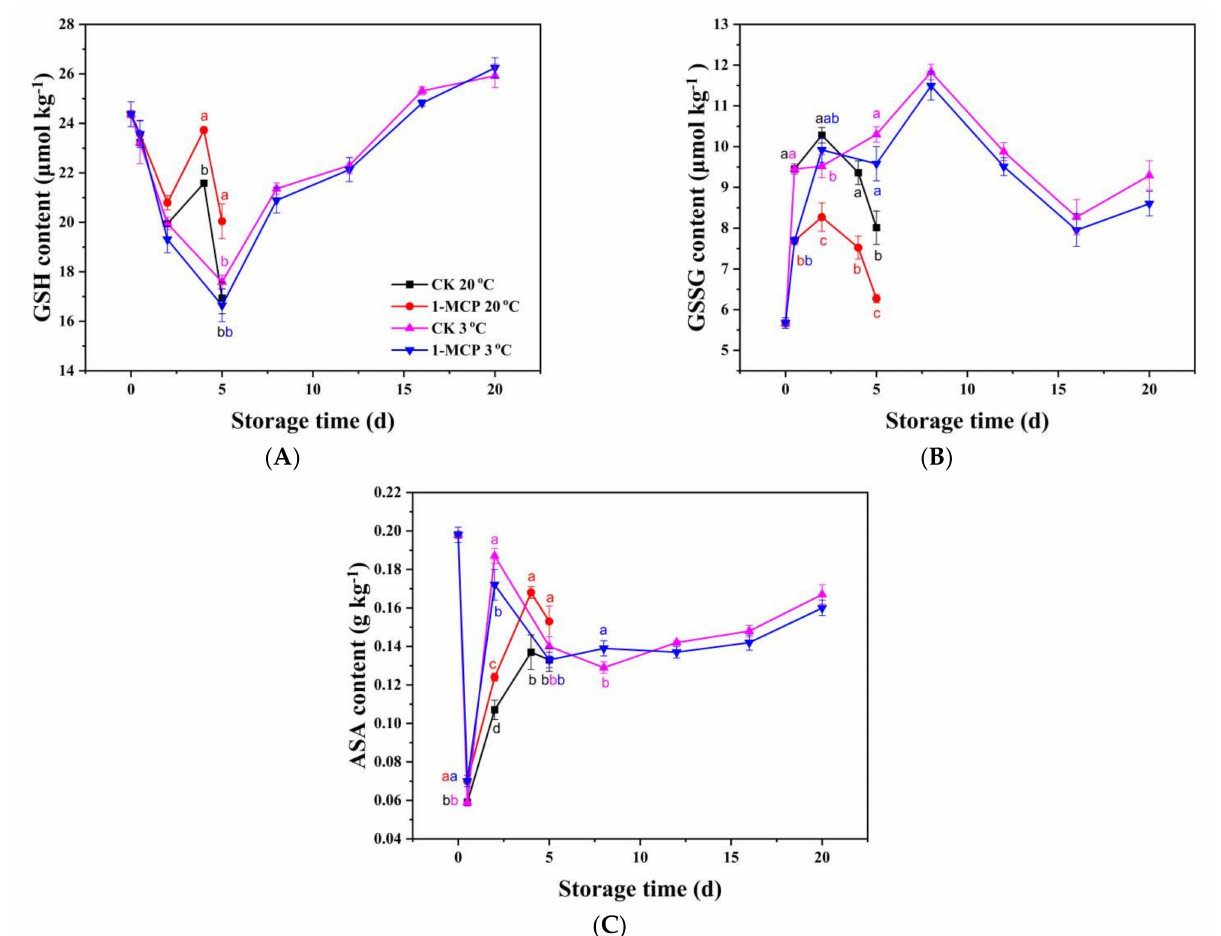
Figure 3. GSH content ( A ), GSSG content ( B ) and ASA content ( C ) of 1-MCP treated and untreated chives during storage at 20 ◦ C and 3 ◦ C. Data are expressed as the mean of triplicate samples. Vertical bars represent the standard errors of the means. The different letters at each time point indicate a difference among the chive